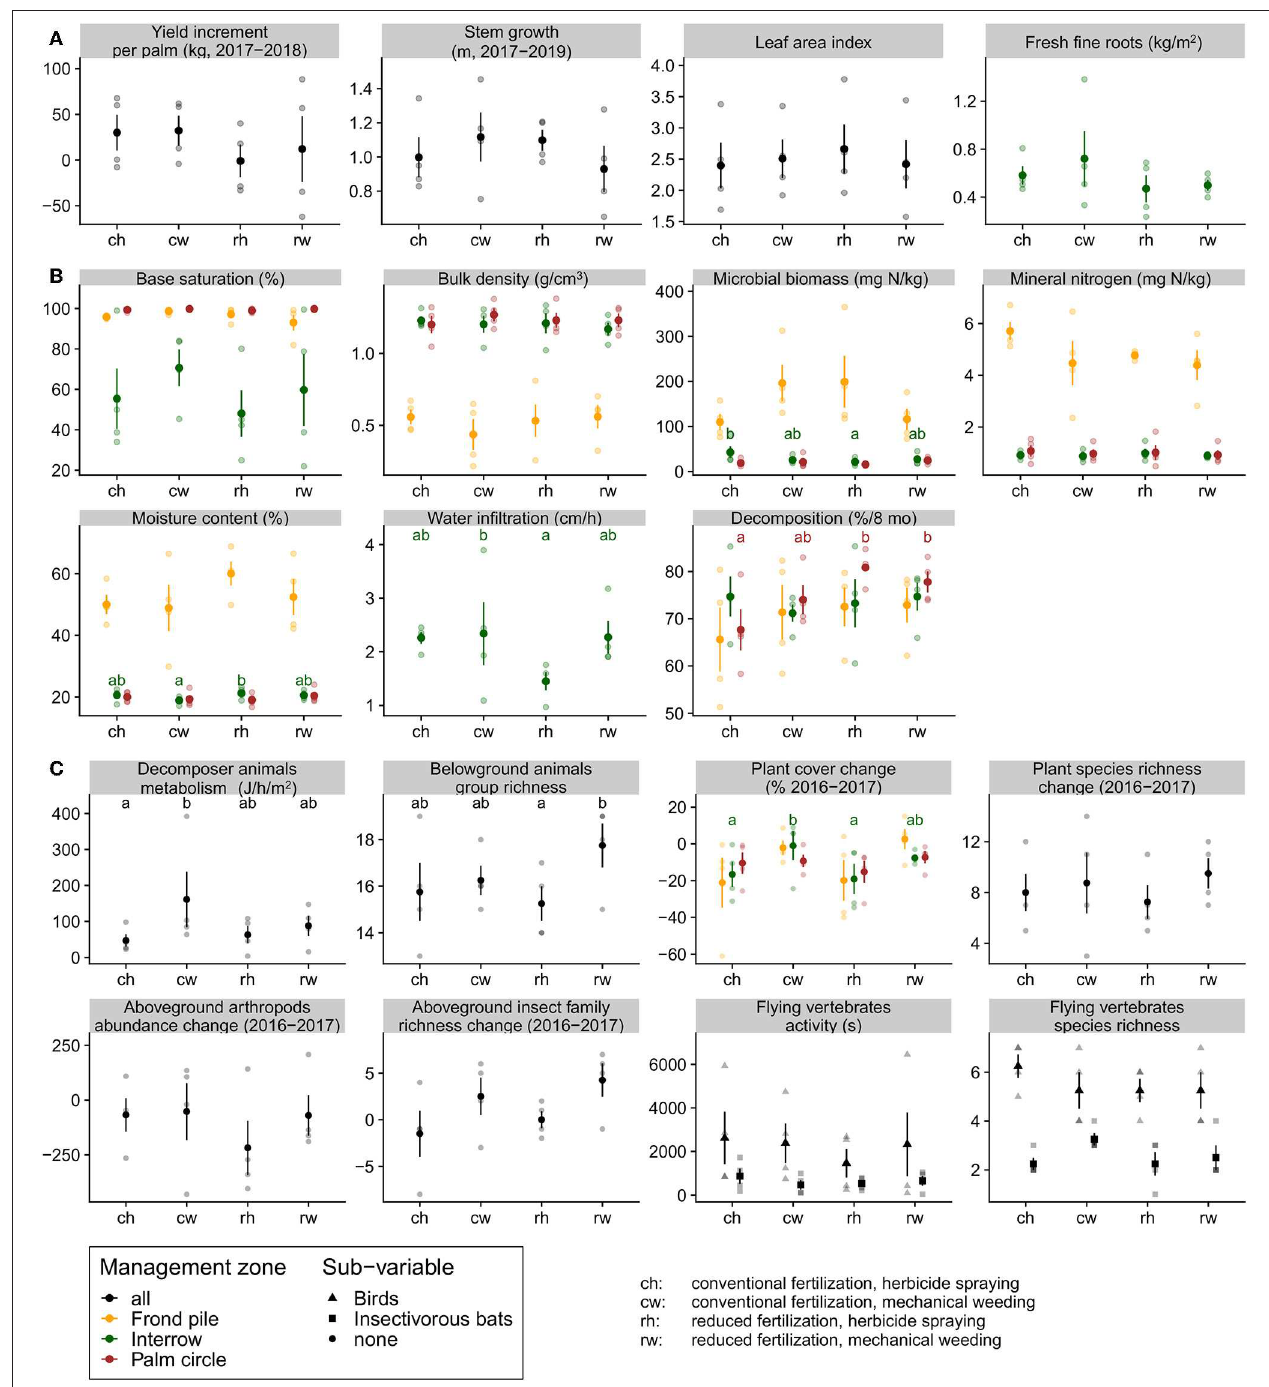
FIGURE 2 | Responses of (A) oil palms condition and productivity, (B) soil nutrients and functions, (C) above- and belowground organisms to the fertilizing and weed control treatments. Data points are indicated with semi-transparent dots. Mean values are indicated with bigger, opaque dots. Error bars show standard errors of the mean, and statistically significant differences between means are shown with distinct letters, color-coded according to the management zone.